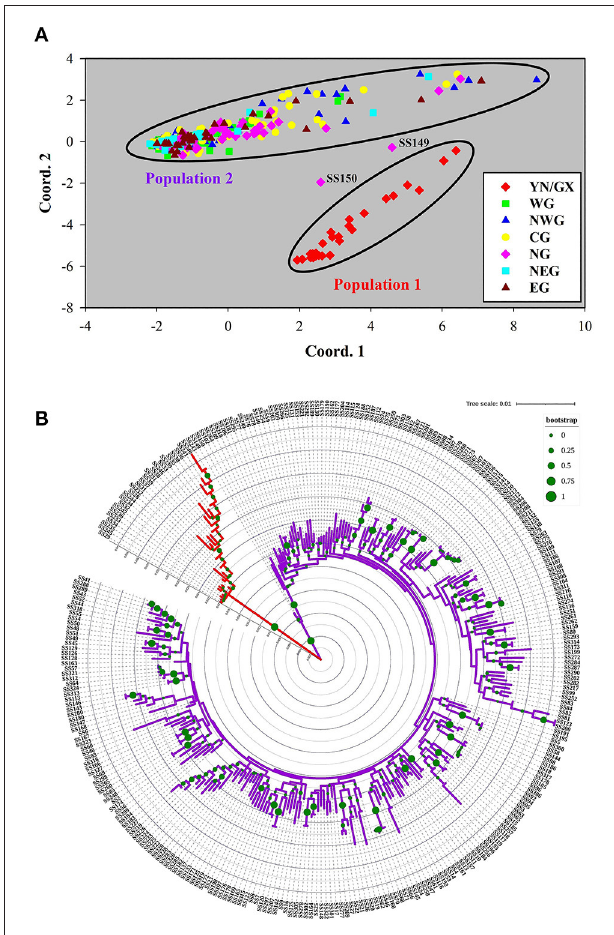
FIGURE 4 | Principal coordinates analysis (PCoA) of 302 S. superba accessions. (A) Genetic distance was used to conduct PCoA. The samples were colored into seven subpopulations according to the geographical distribution in Figure 1 . (B) Phylogenetic tree of 302 accessions. The tree was constructed using the maximum likelihood method in MEGA 6.0 with 1,000 bootstrap replicates. Major differentiations existed among the branches with different colors.